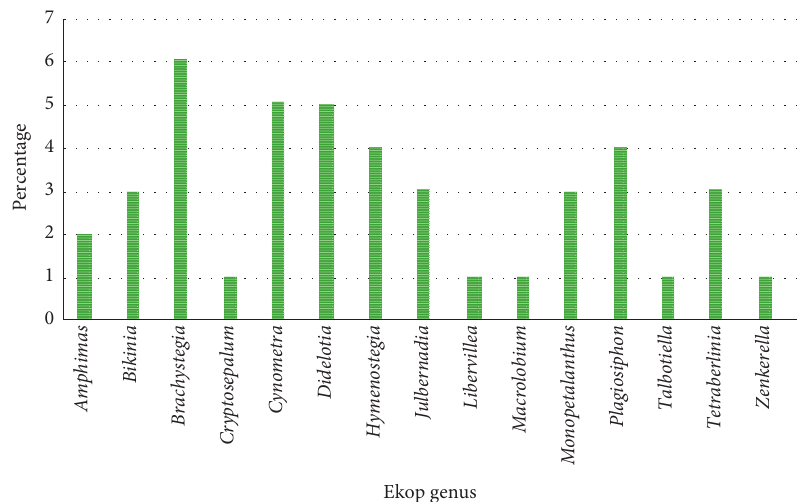
Figure 2: Main Ekop genus collected in Cameroon.